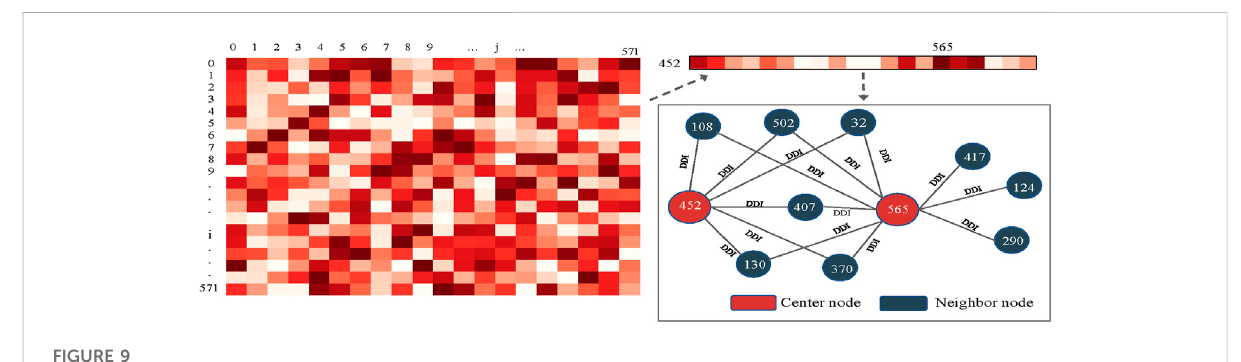
FIGURE 9 Node-level attention distribution and